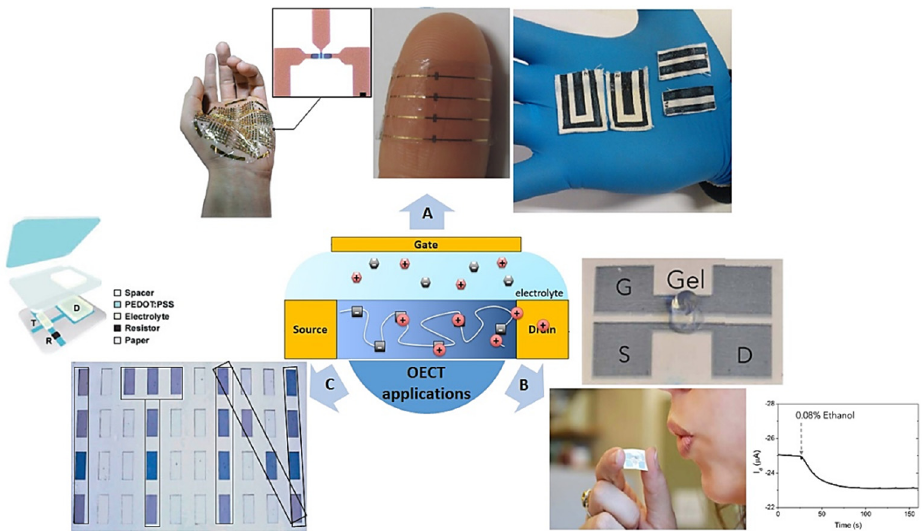
Figure 7. Flexible and wearable devices based on OECTs. ( A ) Flexible printed sensors for wearable and e-skin applications [17,137] (with permission from Springer Nature). ( B ) Paper-printed alcohol sensor [138] (with permission from Springer Nature). ( C ) OECT-based logic circuit: the message “ITN” is projected by electro-chromic properties [149] (with permission from John Wiley and Sons).